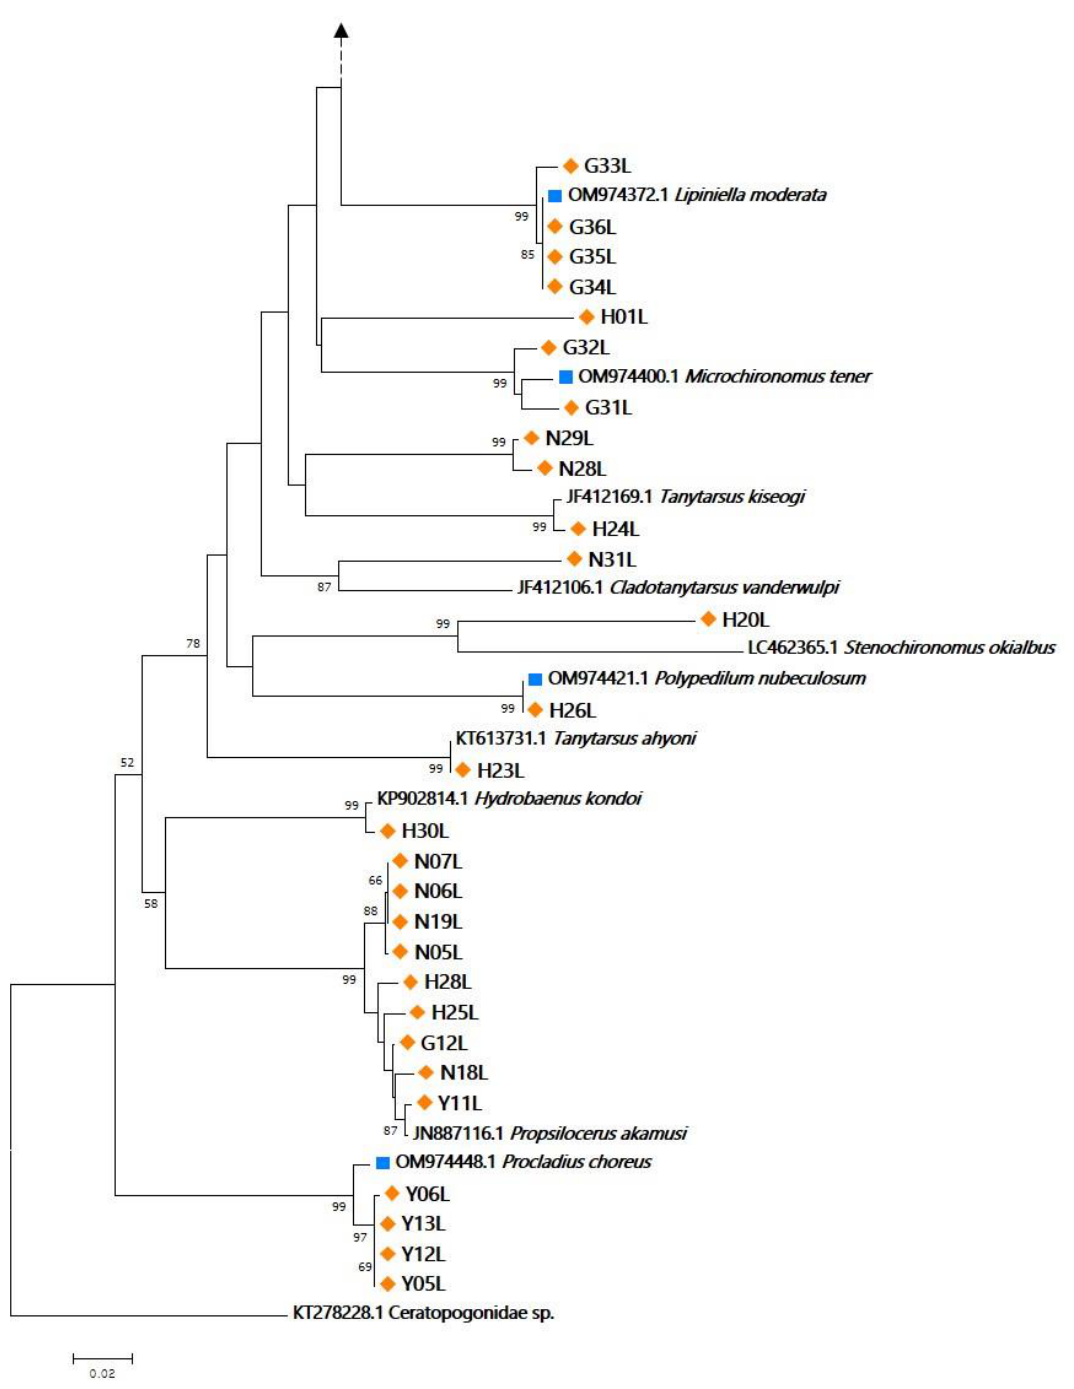
Figure 2. Neighbor-joining tree of 79 cytochrome oxidase I ( COI ) sequences from larval and adult chironomid specimens. Sequences from larval and adult specimens are marked using orange diamonds and blue squares, respectively, and the other of adult reference sequences from NCBI are unmarked.